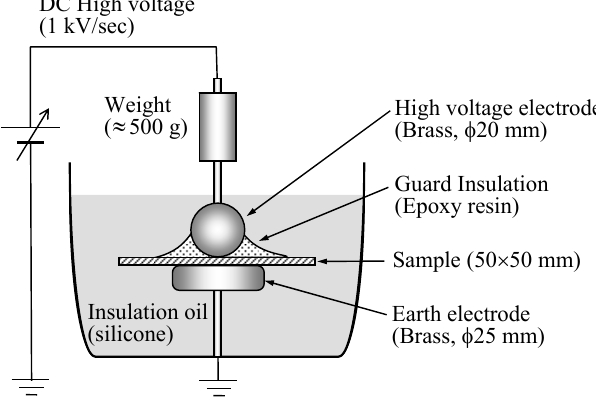
Figure 3. Experimental system for measuring dielectric breakdown strength.